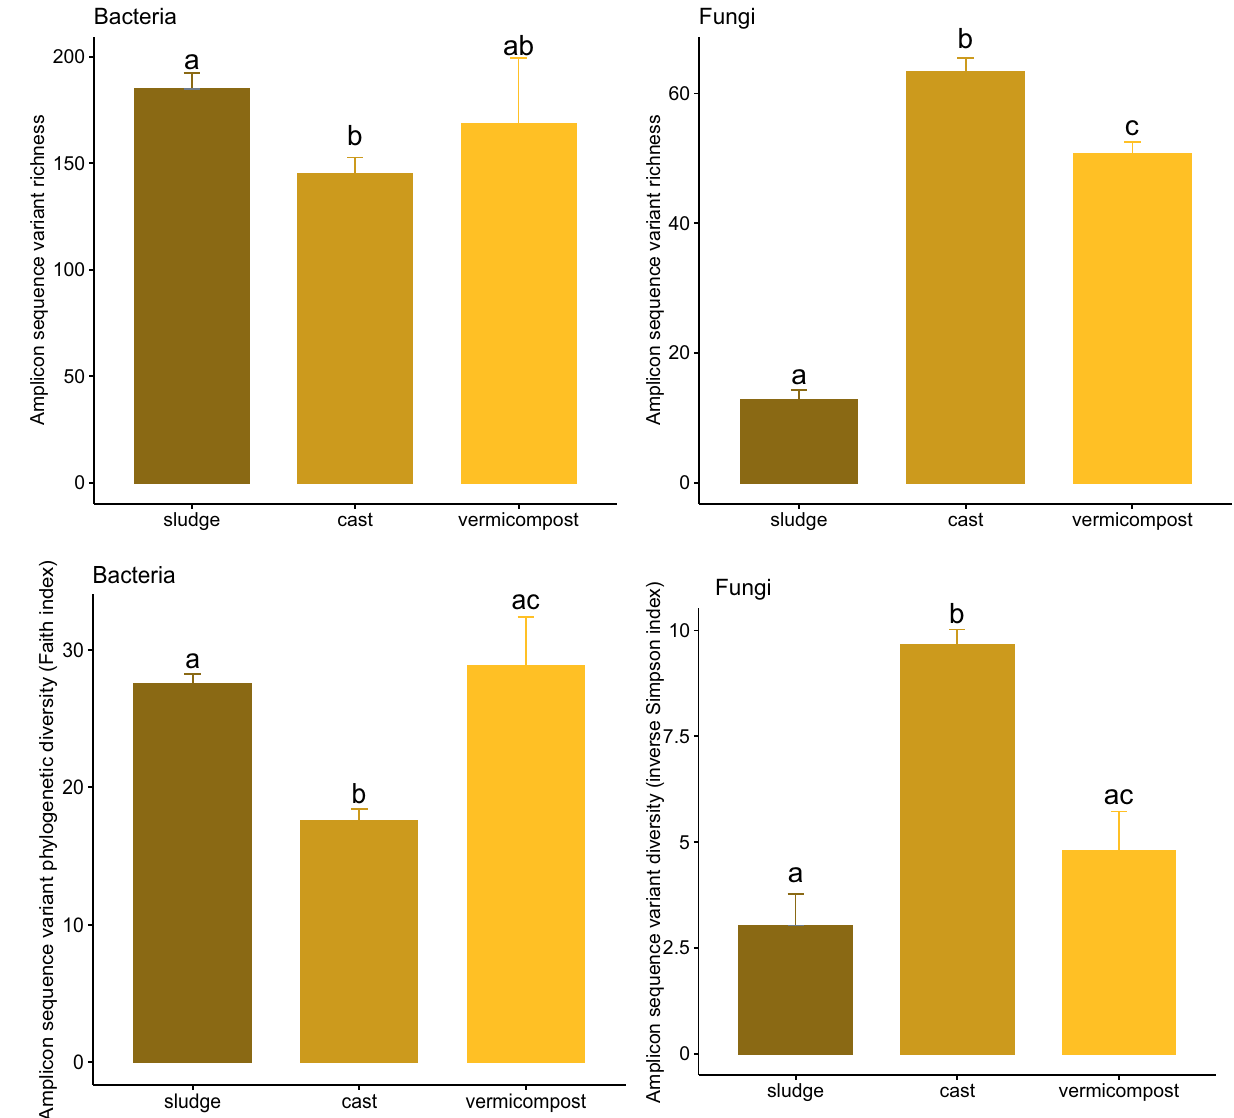
Figure 3. Changes in α-diversity of bacterial and fungal communities during vermicomposting of sewage sludge denoted by observed ASV richness (top) and the Faith and inverse Simpson index (bottom for bacteria and fungi respectively). Different letters indicate significant differences between sewage sludge, fresh earthworm casts and vermicompost (paired Wilcoxon test, FDR